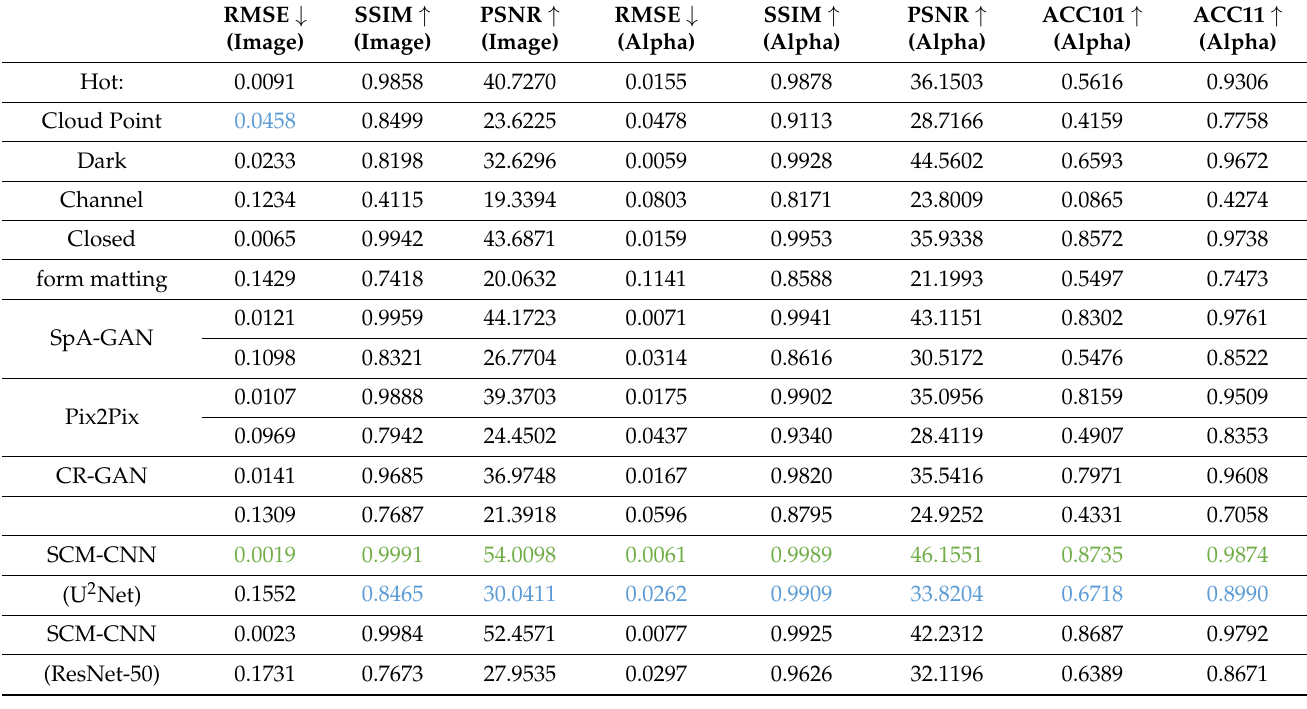
Table 2. Comparison of classification metrics for multiple cloud removal methods. Two metrics were obtained for each cloud removal method, representing the method’s optimal and average values. By comparing multiple methods, we use green and blue to denote the best metrics values obtained by each method.